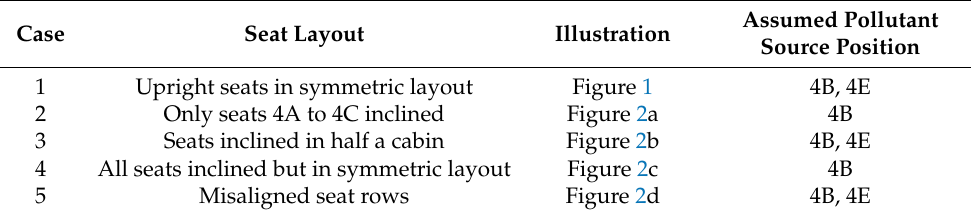
Figure 2. Geometric models of the aircraft cabin with different seat arrangements: ( a ) seats 4A to 4C inclined, ( b ) seats A to C inclined, ( c ) all of the seats inclined, ( d ) planar view of misaligned seat rows. Table 4. Case design overview.